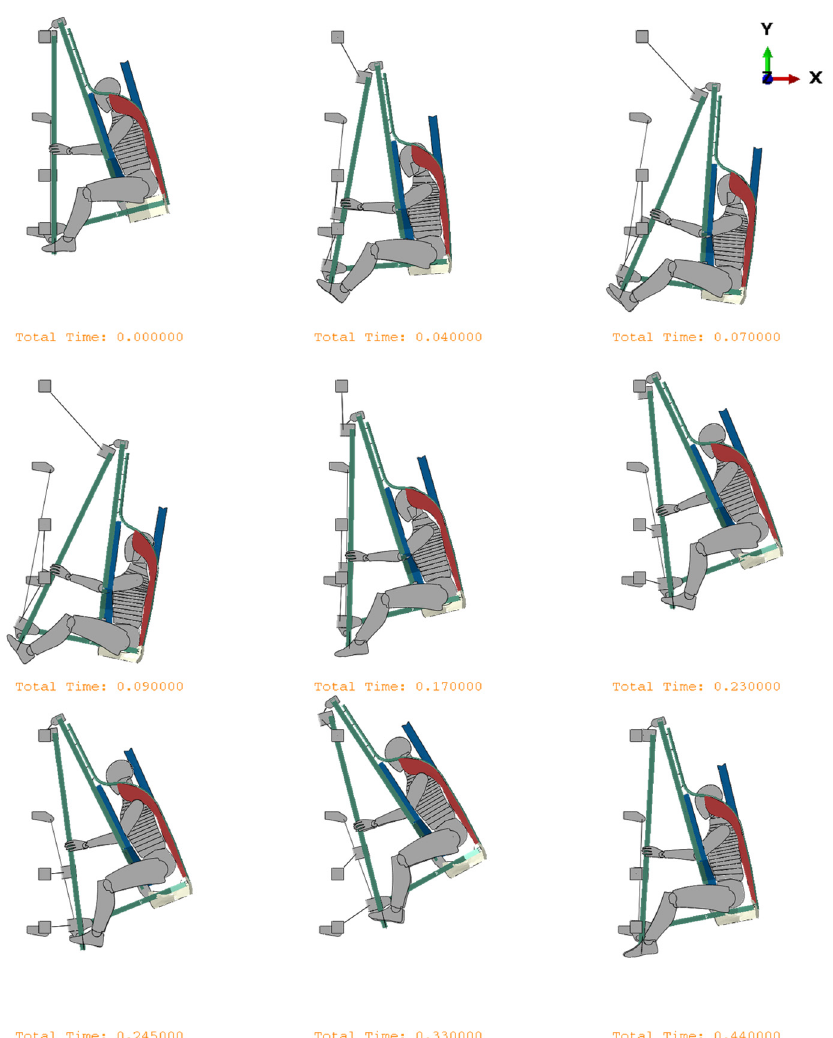
Figure 10. Vertical fall (situation 1) critical instants (t = 0, 40, 70, 90, 170, 230, 245, 330, 440